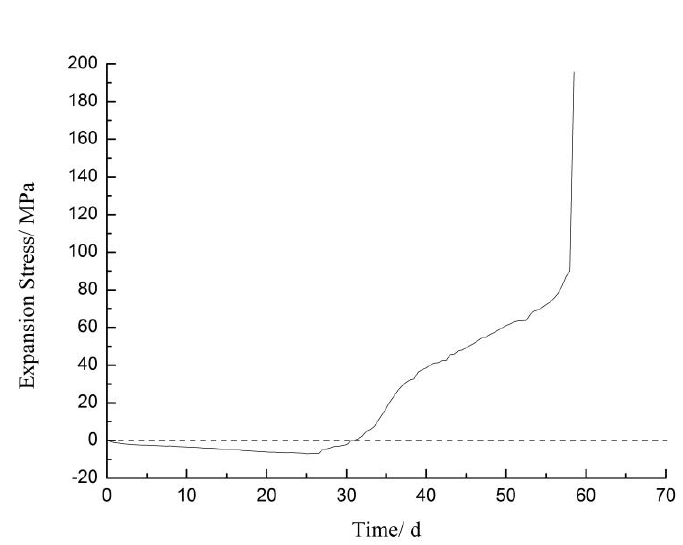
Figure 7. Expansion stress curve of the formed Li 2 SiO 3 .